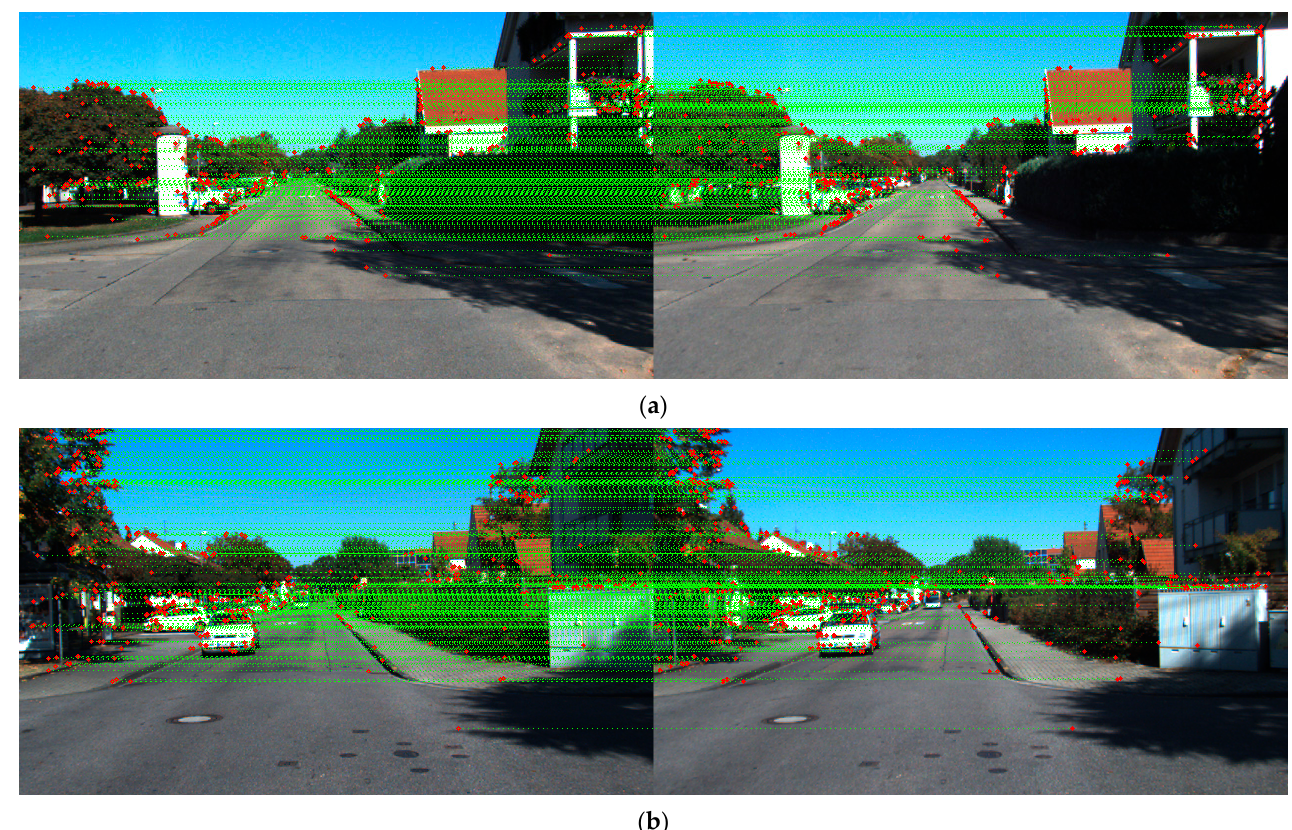
Figure 26. ( a ) Stereo vision images, 05 000000.png from KITTI dataset, are applied to the proposed double E-SIFT with FAP feature matching, resulting in 497 matching pairs between the left and right images; ( b ) Stereo vision images, 00 02566.png from KITTI dataset, are applied to the proposed double E-SIFT with FAP feature matching, resulting in 560 matching pairs between the left and right images.